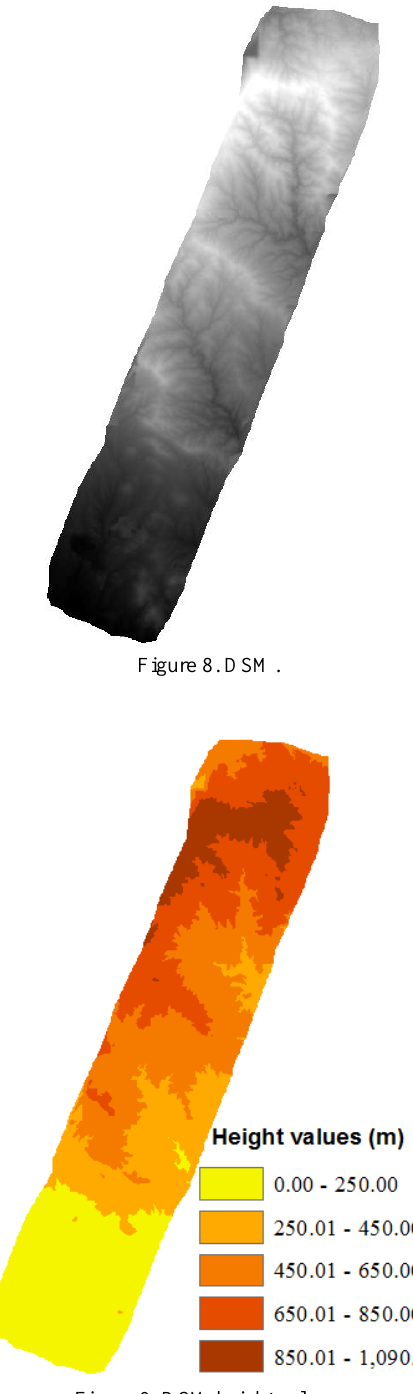
Figure 9. DSM height values.